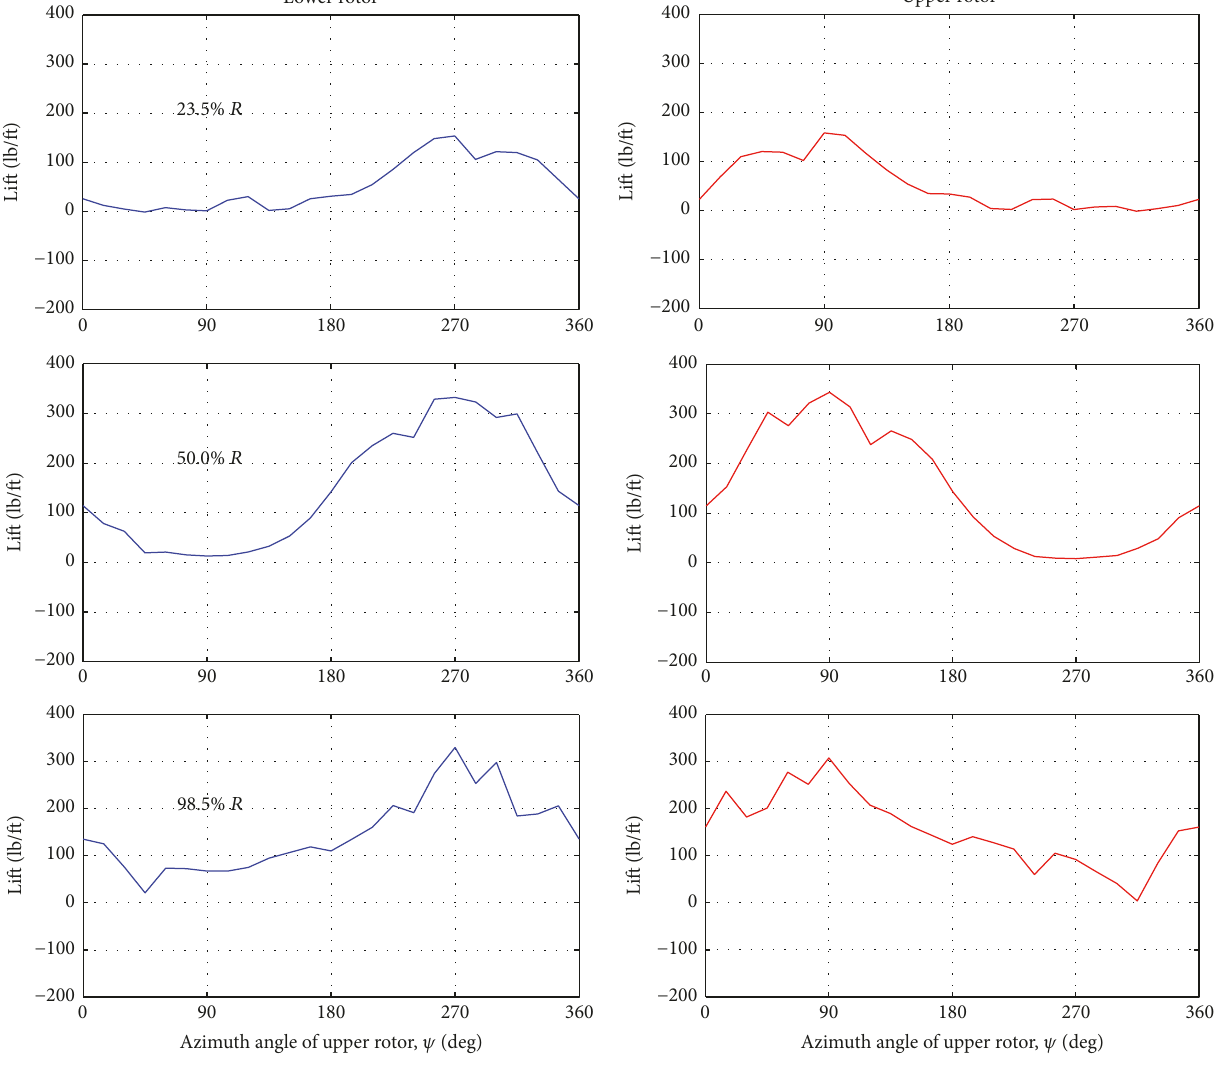
Figure 17: Blade section lifts at 140 knots in compound helicopter mode (LOS =